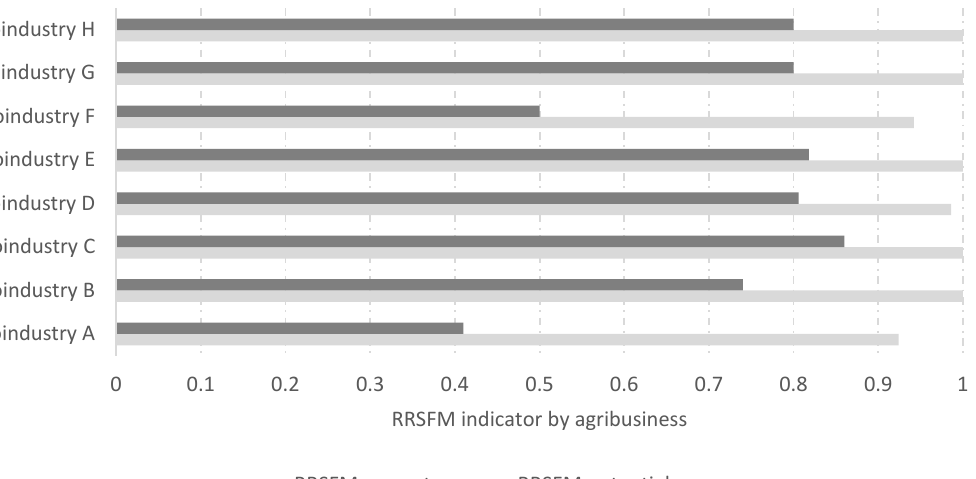
Figure 6. Current and potential RRSFM indicator of the agro-industries of the Casanare Department under the Material Flows approach.